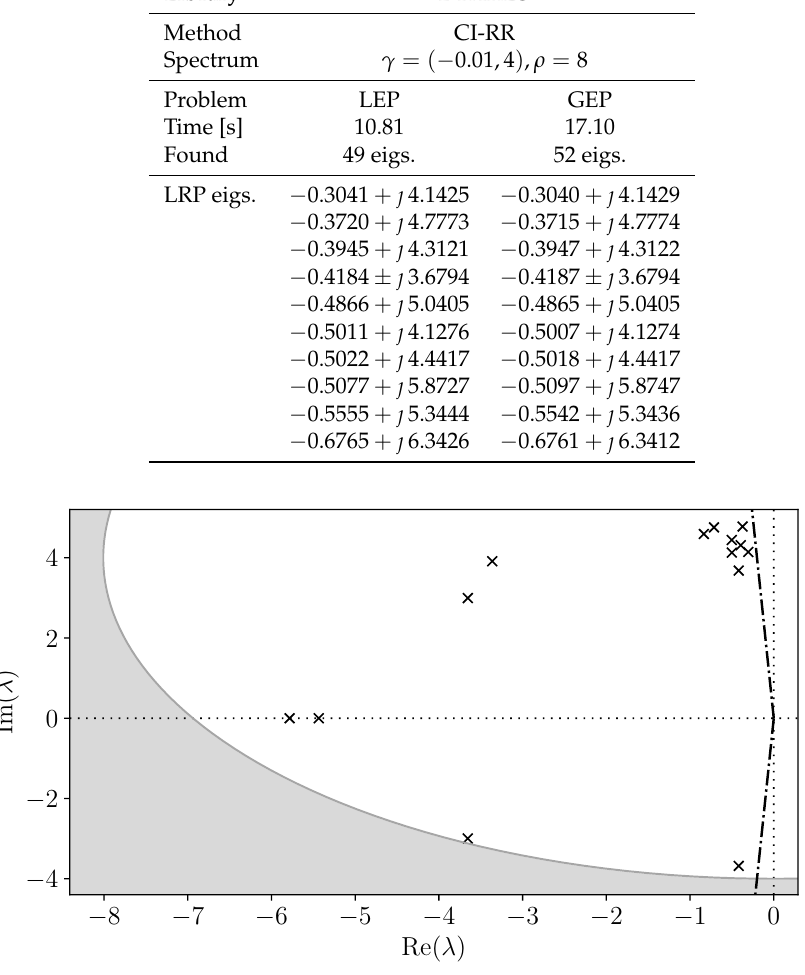
Figure 4. AIITS: root loci obtained with z-PARES,